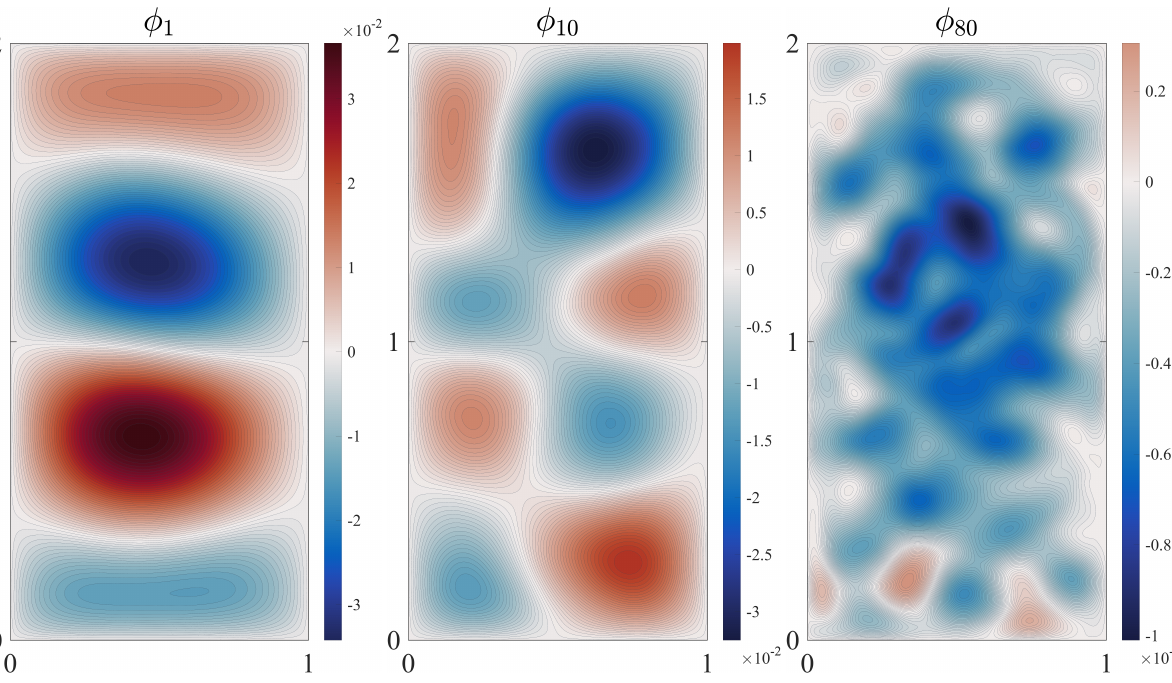
Figure 8. Streamfunction basis functions: φ 1 , φ 10 , and φ 80